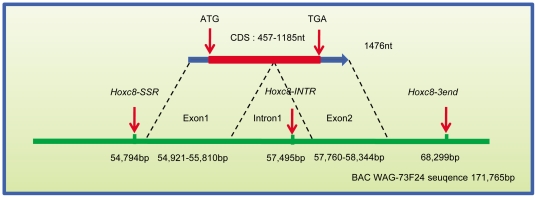
Gene structure of chicken HOXC8.The two most significant genetic markers in the GWAS of Crest are indicated.